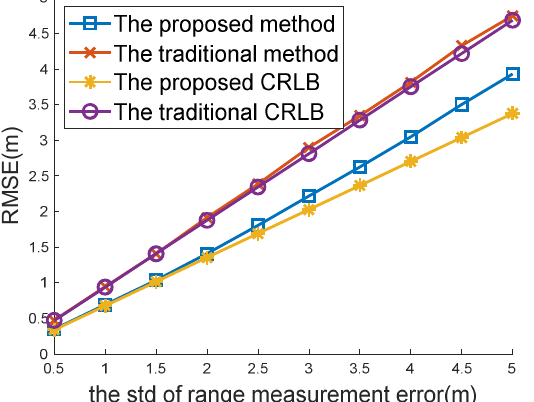
Figure 4. Comparison between the traditional method and the proposed method under different TOA noises.